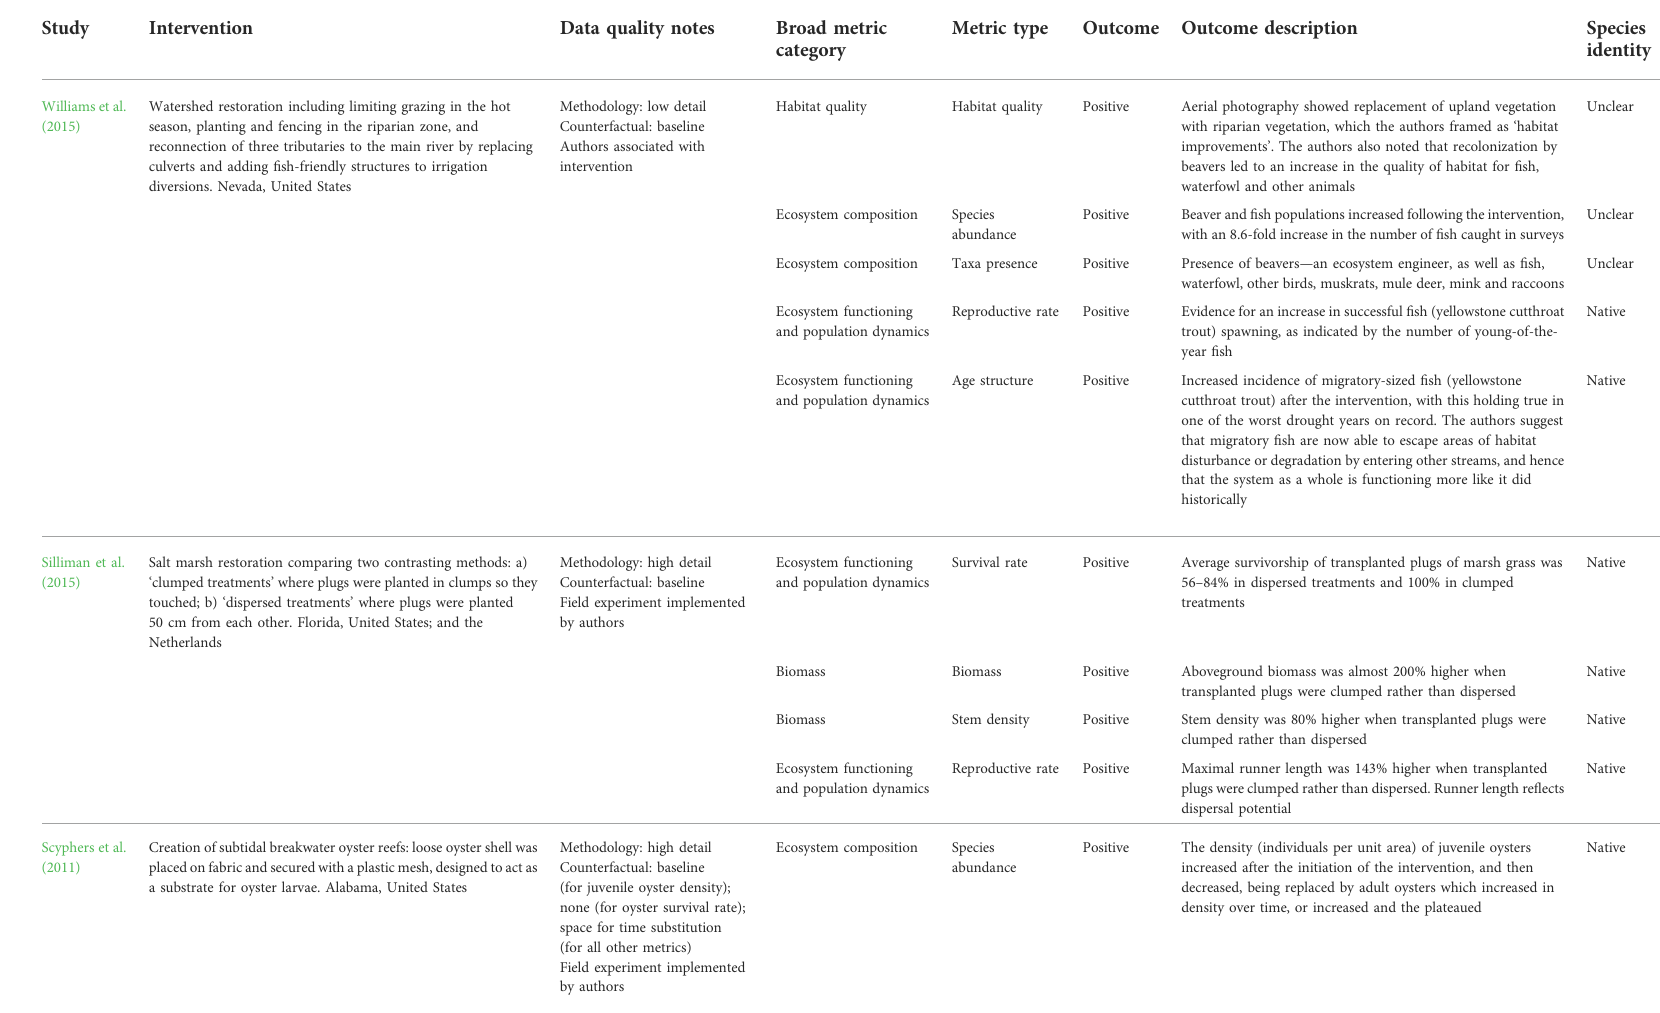
TABLE 3 Examples of ecosystem health outcomes of interventions which were selected to cover a range of habitat and intervention types, each with ecosystem health outcomes across multiple broad metric categories, with either native or unclear species